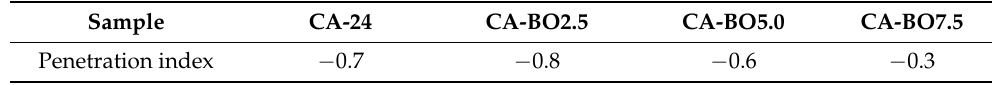
Table 4. Penetration index of the